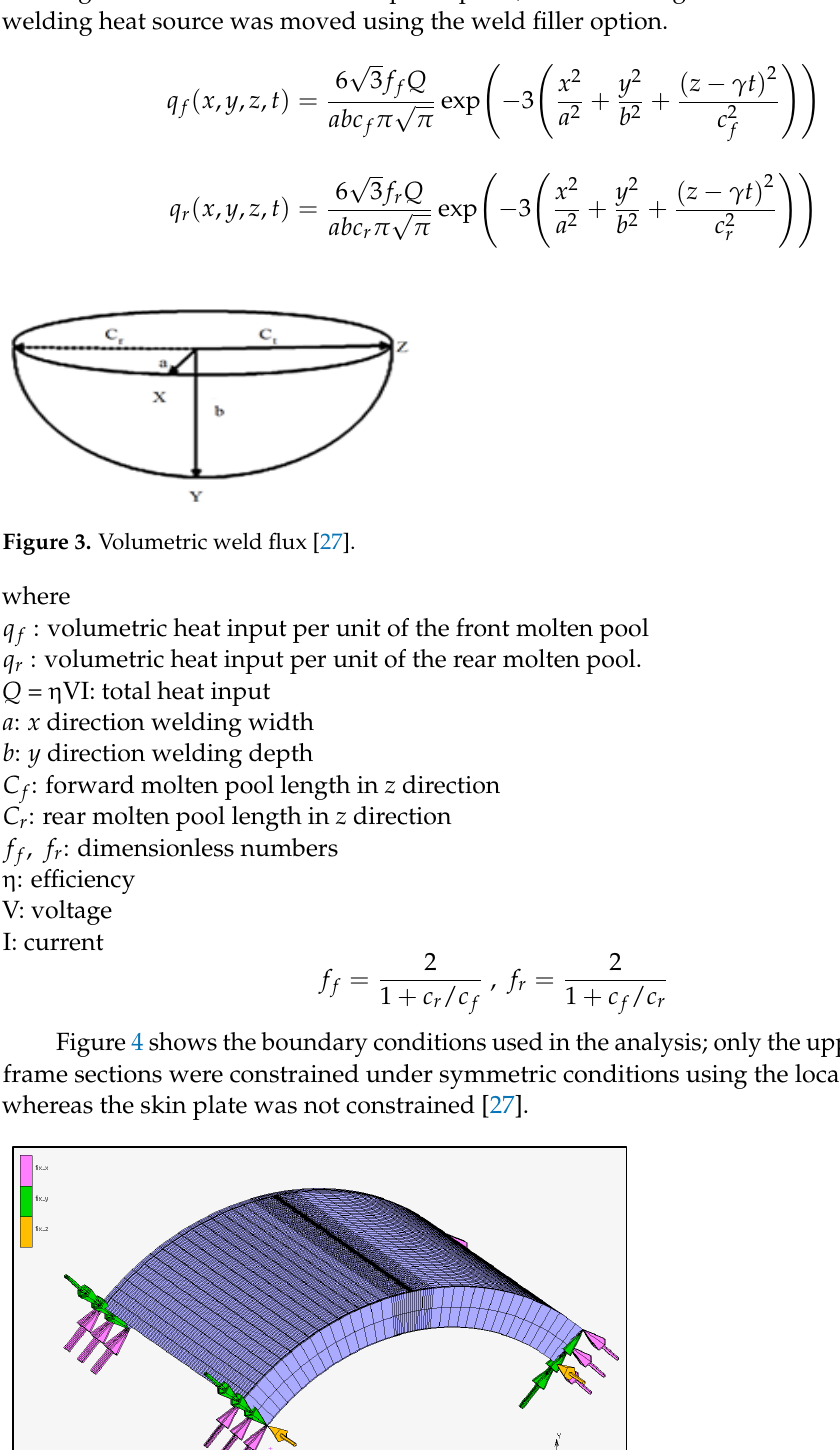
( b ) ( c ) Figure 5. Modeling of pre-stress method: ( a ) pressure plate; ( b ) bolting; ( c ) forced displacement [27]. Figure 5a demonstrates the skin, back, and pressure plates. Tensile stress was in- duced on the skin plate by applying displacement from the inside of the cylinder. The skin plate has a seam weld, whereas the pressure plate is a rigid element that facilitates a forced displacement and is in contact with the back plate. As shown in Figure 5b, the skin and back plates are connected to fasteners (bolts) at intervals of 100 mm in the direction of the